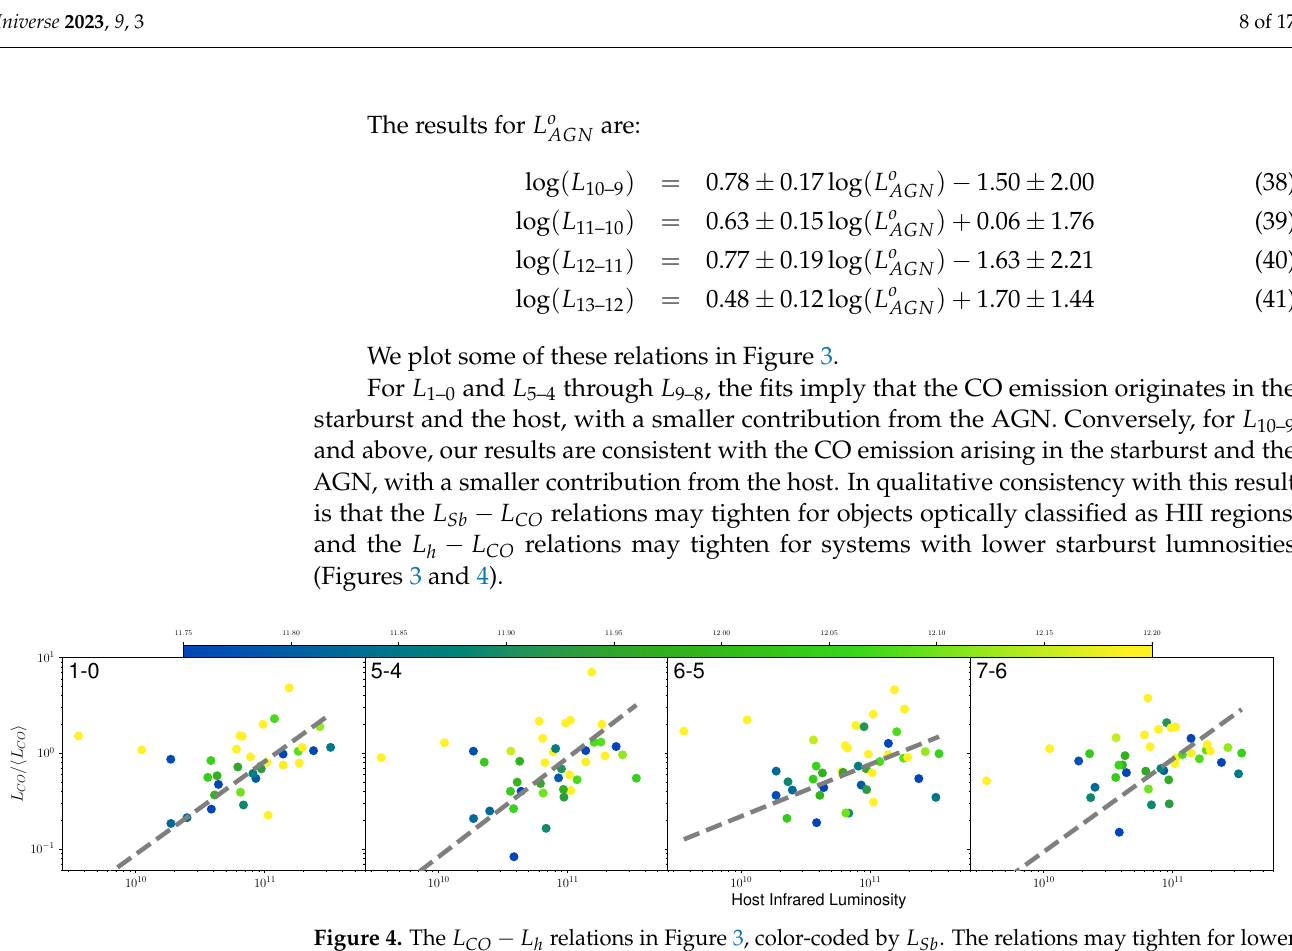
L h relations in Figure 3, color-coded by L Sb . The relations may tighten for lower Figure 4. The L CO − starburst luminosities, consistent with the CO gas being heated by both host and starburst starlight. For L SB and L h , the slopes for the CO 9–8 and below relations are consistent with a linear relation. For CO 10–9 and above, the relations with L SB are also consistent with linearity, though the slopes may start to flatten at CO 13–12. In contrast, the slopes for the relations between CO 10–9 and above, and L o , are all consistent with being AGN